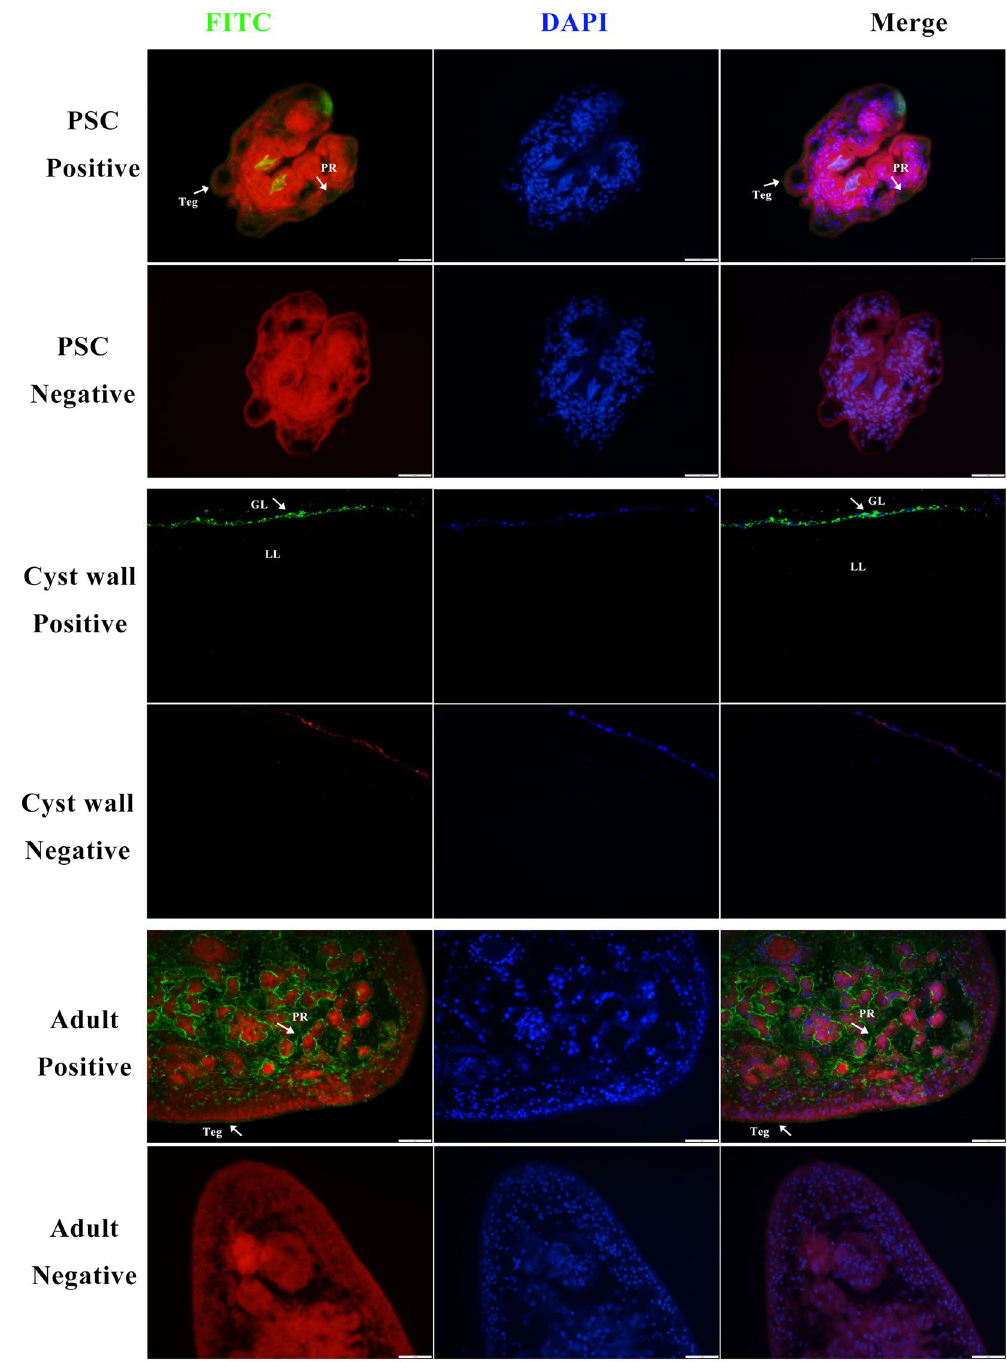
Figure 4. Immunofluorescent localisation of Eg-DHFR in different stages of E. granulosus . Eg-DHFR was localised in the protoscolex, germinal layer and adult worm using specific anti-rEg-DHFR IgG (positive), or preimmune serum (negative). The nucleus DNA was stained with DAPI (blue). Abbreviations: Teg, tegument; PR, parenchymal region; GL, germinal layer; LL, laminated layer. Scale bars: 1